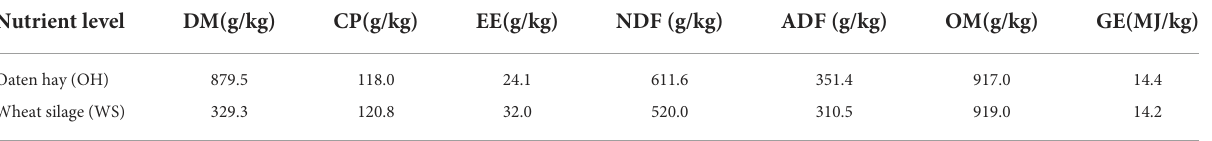
TABLE 1 Nutrient composition of oaten hay and wheat silage on dry matter basis.